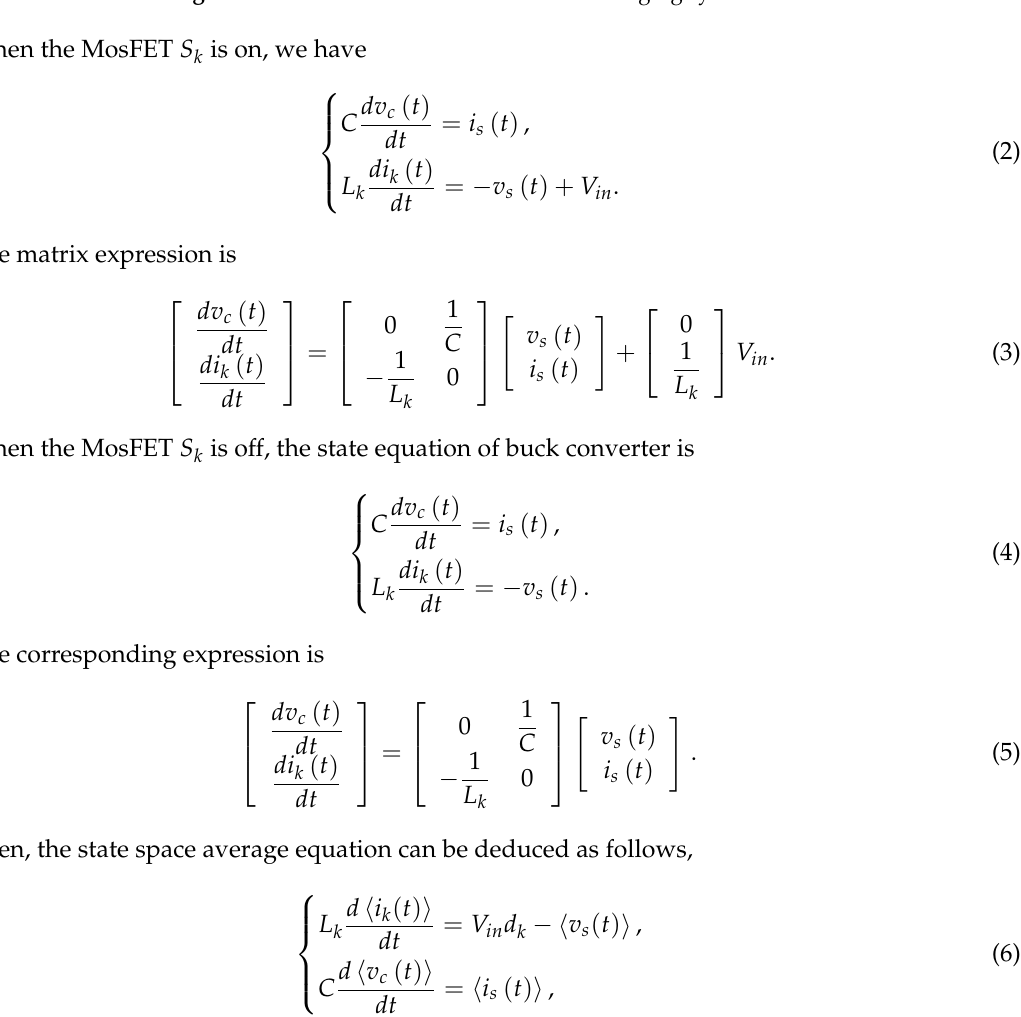
Figure 1. The scheme of the multi-module charging